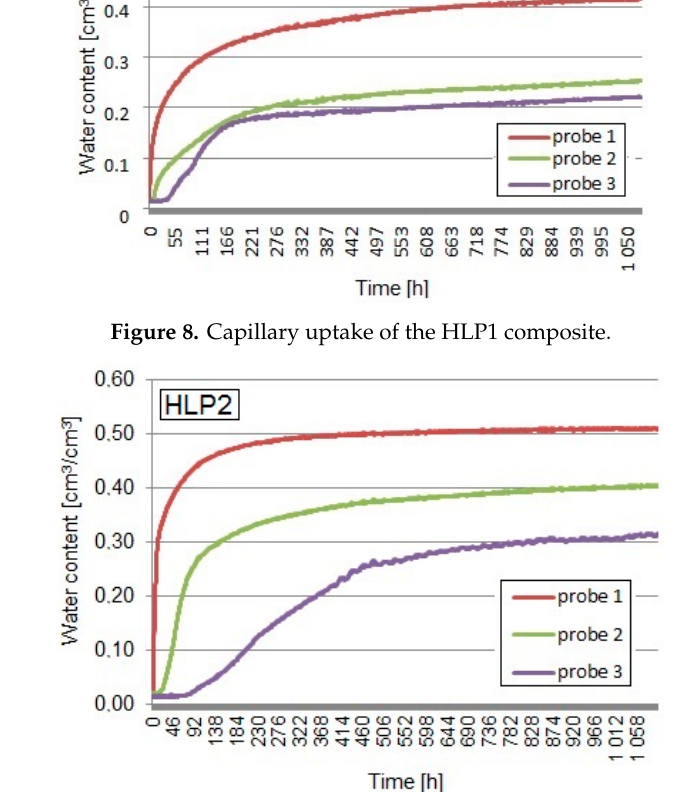
Figure 9. Capillary uptake of the HLP2 composite.